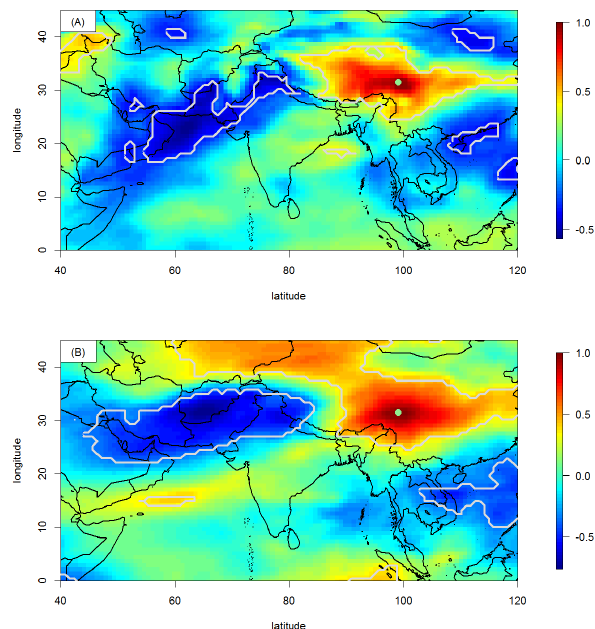
Figure 5. Spatial correlation of July–August relative humidity (ERA interim data, AD 1979–2013) at the (a) 500hPa and (b) 300hPa pressure level. Colour code represents the Pearson corre- lation coefficient. White lines delineate the 95% significance level. Proxy location is shown by the light green